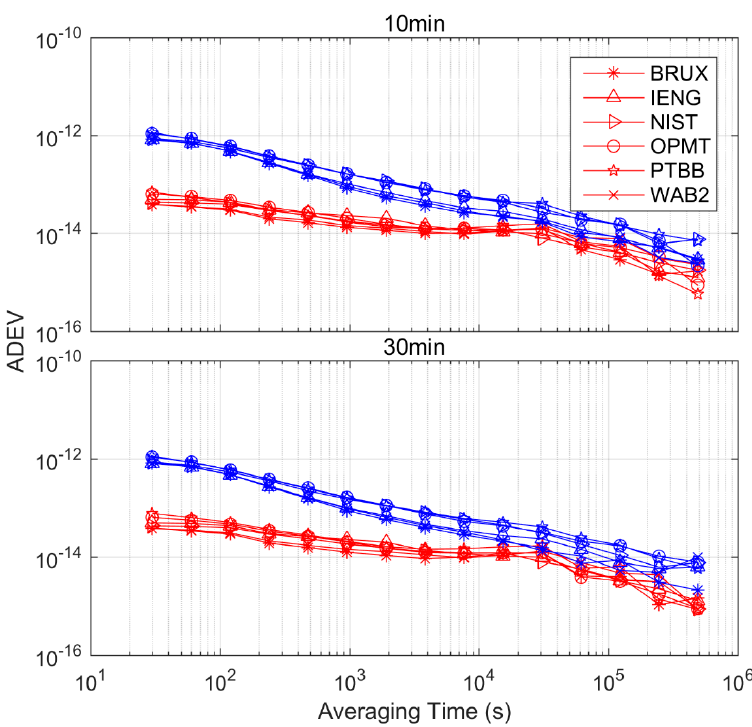
Figure 7. Allan deviation of scheme 1 ( blue ) and scheme 2 ( red ) at six stations for observation interruptions of 10 and 30 min.